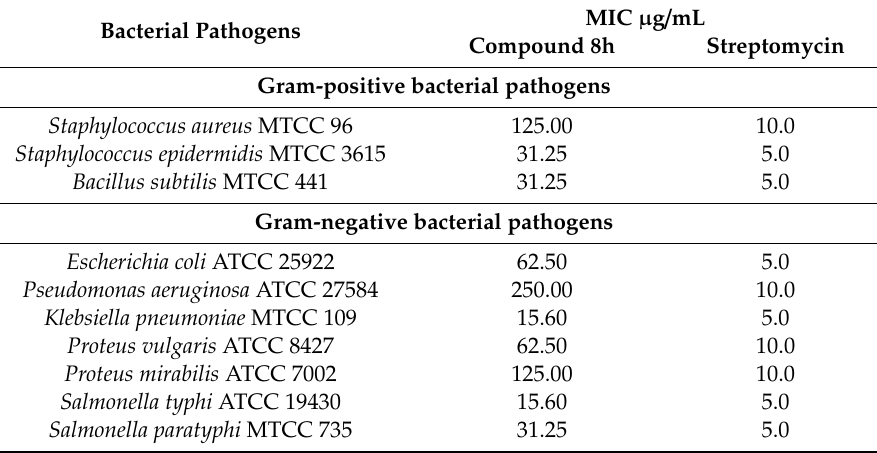
Table 2. Minimum inhibitory concentration of dispiropyrrolidines compound 8h and streptomycin.